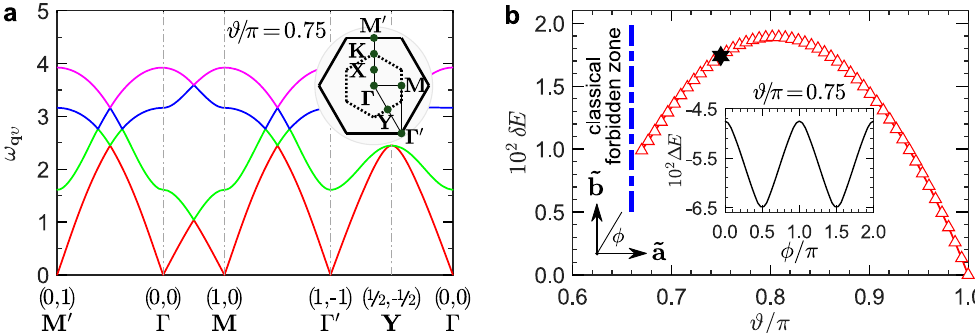
Fig. 3 Spin-wave analysis of the stripy phase. a Four branches of the magnon spectra ω q υ in the stripy phase where ϑ / π = 0.75. The path along the symmetry directions in the momentum space is depicted in the inset. b Energy barrier δ E between the stripy phases of different orientations in the classically allowed zone. Inset: Quantum energy correction Δ E ( ϕ ) vs angle ϕ suited at the e a - to ϑ / π = 0.75, which is marked as a black hexagram in the main panel.